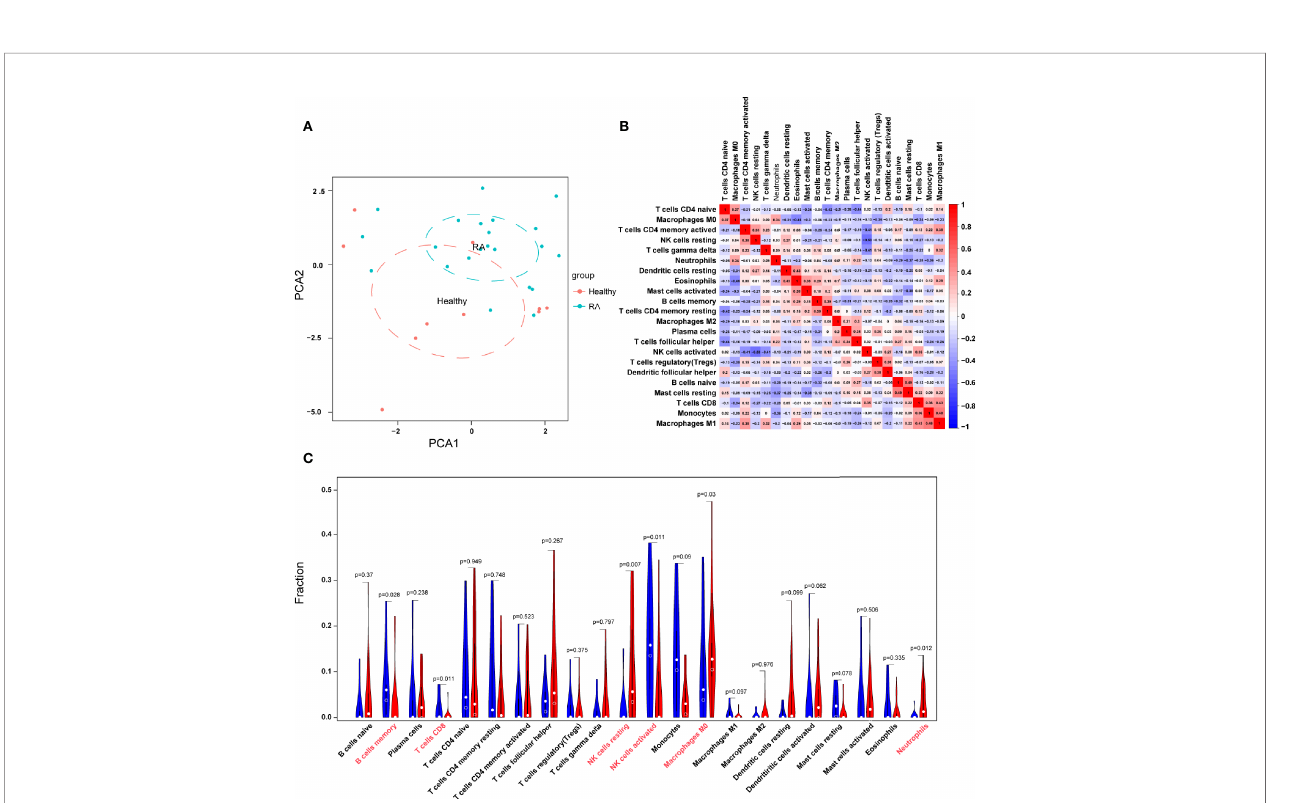
FIGURE 7 | Evaluation and visualization of immune cell in fi ltration. (A) PCA cluster plot of immune cell in fi ltration between RA samples and control samples. (B) Heatmap of correlation in 22 types of immune cells. The size of the colored squares represents the strength of the correlation; red represents a positive correlation, and blue represents a negative correlation. Darker color implies stronger association. (C) Violin diagram of the proportion of 22 types of immune cells. The red marks represent the difference in in fi ltration between the two groups of